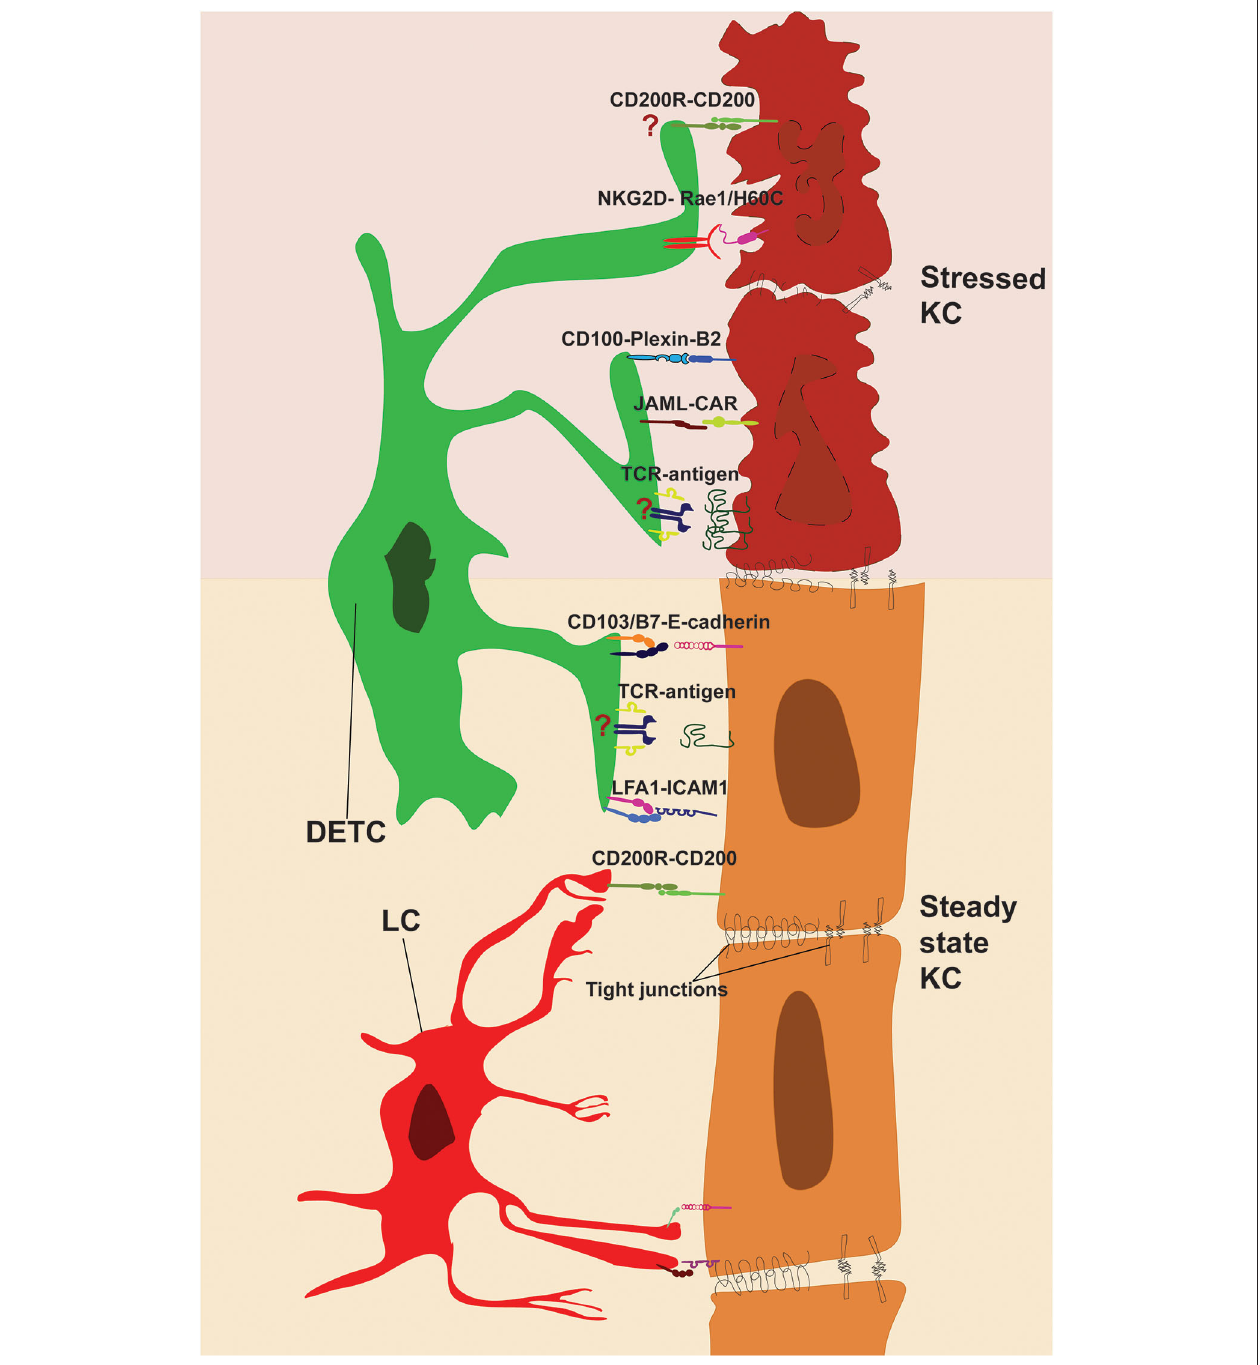
FIGURE 2 | Direct cell-cell contacts regulating immune surveillance of epidermis. DETC and KC form stable interactions during steady state (bottom). TCR and adhesion molecules LFA-1 and CD103 are enriched and engaged with KC-derived ligands at tips of DETC protrusions. LC-KC interaction via CD200R-CD200 suppresses LC activation at steady state. Stressed KC (top) upregulates costimulatory ligands and DETC-specific antigens, which activate DETC via JAML, CD100, NKG2D, and TCR. However, further research is needed to pinpoint the role of antigen presentation and CD200-CD200R signaling in shaping DETC effector functions (indicated by